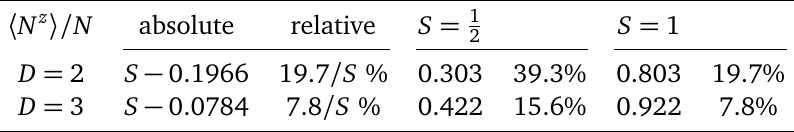
Table 4.2: The order parameter density in the Heisenberg antiferromagnet on square and cubic lattices with z = 2 D . Indicated first for general spin, and then for the specific cases of S = 1 / 2 and S = 1, are the absolute value of the order parameter expectation value, and its relative suppression compared to the classical expectation value 〈 N z 〉 / N = S . 〈 N z 〉 / N absolute relative S = 1 S = 1 2 D = 2 S − 0.1966 19.7 / S % 0.303 39.3% 0.803 19.7% D = 3 S − 0.0784 7.8 / S % 0.422 15.6% 0.922